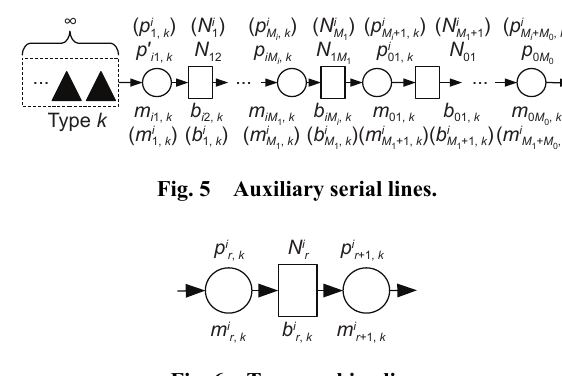
Fig. 4 Multiple groups of assembly system with single job.